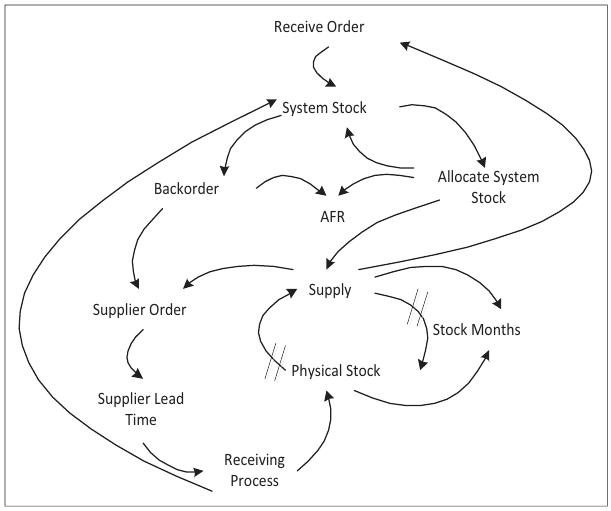
FIGURE 1: Comprehensive view of the supply chain, including supplier. TABLE 1: Differences in factors for local and imported parts suppliers.